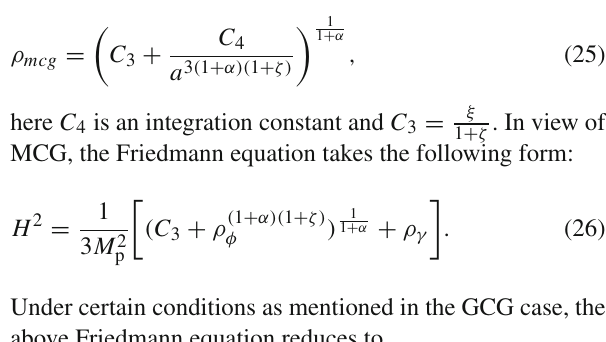
Fig. 5 Plot of r versus n s for GCG model in weak (left panel) and strong (right panel) dissipative regimes for negative potential with n = − 1 0 . 0398. The results for negative quadratic and quartic poten- tial are shown in Table 3. The values of tensor-to-scalar ratio and spectral index are in consistence with observational WMAP9 [69] and Planck 2015 [70]